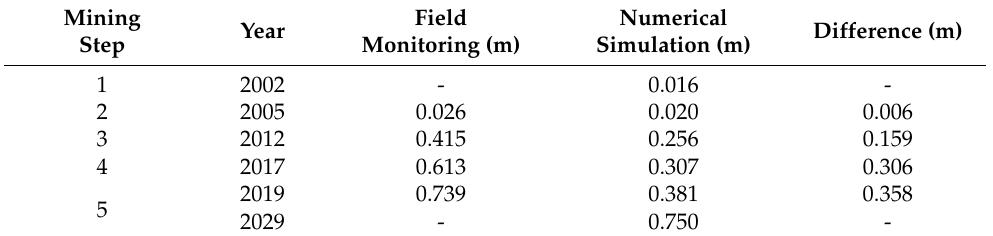
Table 2. Comparison of on-site monitoring results and simulation calculation results after each stage.